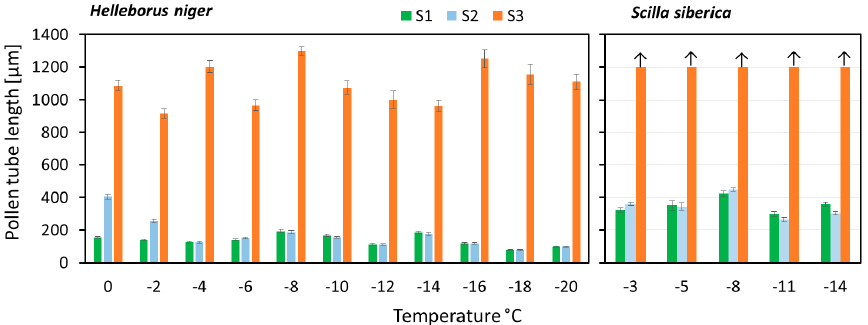
Figure 6. Frost after-effects on pollen tube growth in the winter flowering Helleborus niger and the early spring flowering Scilla siberica . Bars show the mean pollen tube lengths (± SE) at the end of the cooling down phase (S1), the frost phase (S2), and the 24 h recovery phase (S3) in the step cooling experiment with different target temperatures. Arrows: Pollen tubes were too long to be measured. Male gametophytes of the spring flowering Pulmonaria and of the tested summer-flowering species lost functionality more or less rapidly below zero (Figure 7). In all species, pollen germination was saturated during the cooling down phase. Therefore, it can be assumed that growing pollen tubes were damaged by frost and did not grow further after warming up. Germinating pollen of Oenothera was particularly frost sensitive. Gametophytes of Lotus and Dianthus did not recover below − 2 °C. Pollen tubes of Epilobium grew further after the frost exposure, but the increment decreased with the treatment temperature.